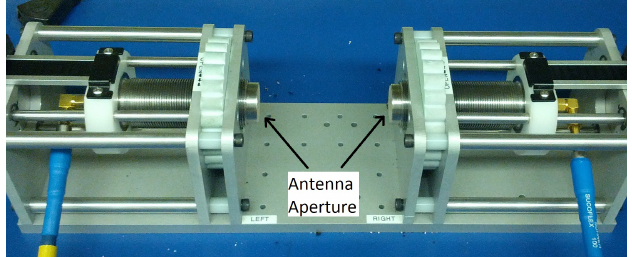
Figure 1. The system used to measure the transmission coefficients of breast phantoms.